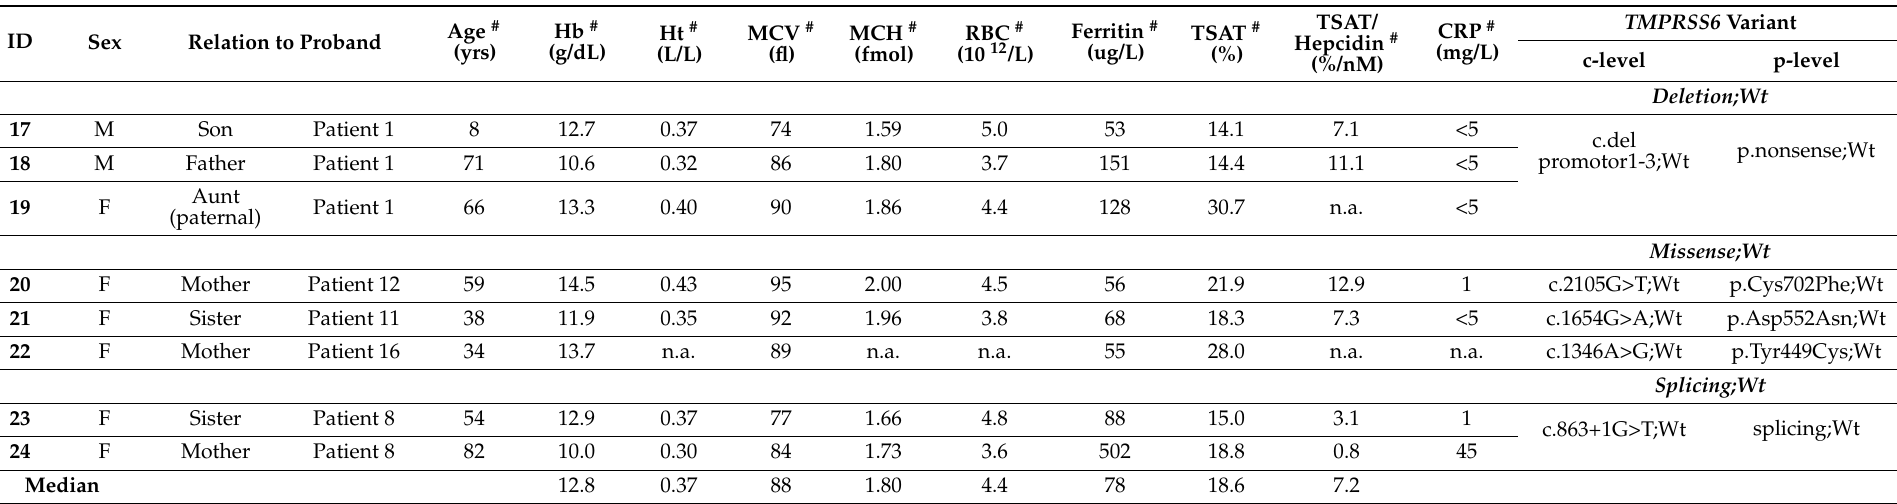
Table 2. Characteristics of relatives with a monoallelic TMPRSS6 variant but without IRIDA